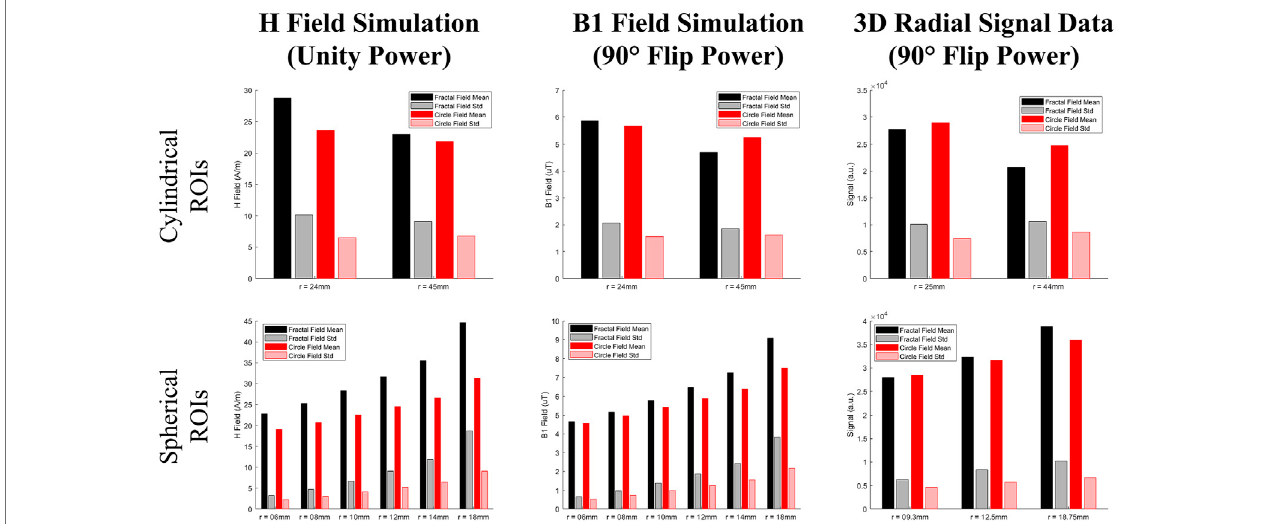
FIGURE6| ThemeansandstandarddeviationsovervariousROIsshownin Figure3 forthesimulatedH fi eld(giveninA/m),thepowercompensatedsimulated B 1 fi eld (given in μ T), and the measured signal from the 3D radial volume data (given in a.u.) for both the circular and fractal coil. As the standard deviation of the ROIs was usedasthemainmetricfordeterminingagivencoil ’ shomogeneity,thestandarddeviationsareshownforcomparisonastheirownbarintheplot.TheradiiofeachROIis the label for each set of bars.